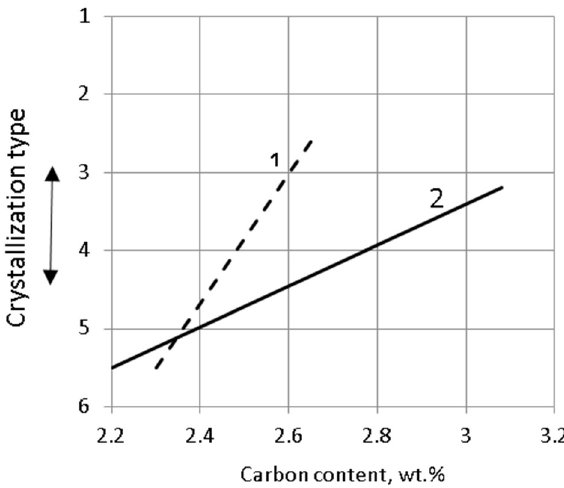
Figure 2. Influence of carbon in molten metal on type of dendritic crystallisation during production of white iron castings: (1) melt in which metal charge contains 20% pig iron and 80% steel scrap; (2) melt in which metal charge consists of 25% pig iron and 75% steel scrap [2].